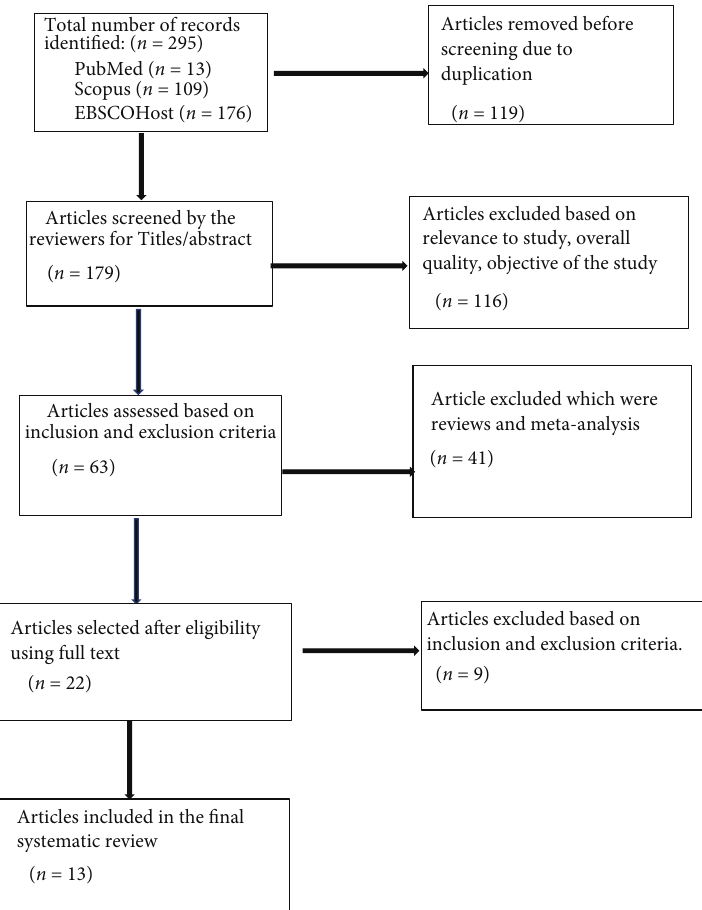
Figure 2: The PRISMA protocol diagram for study